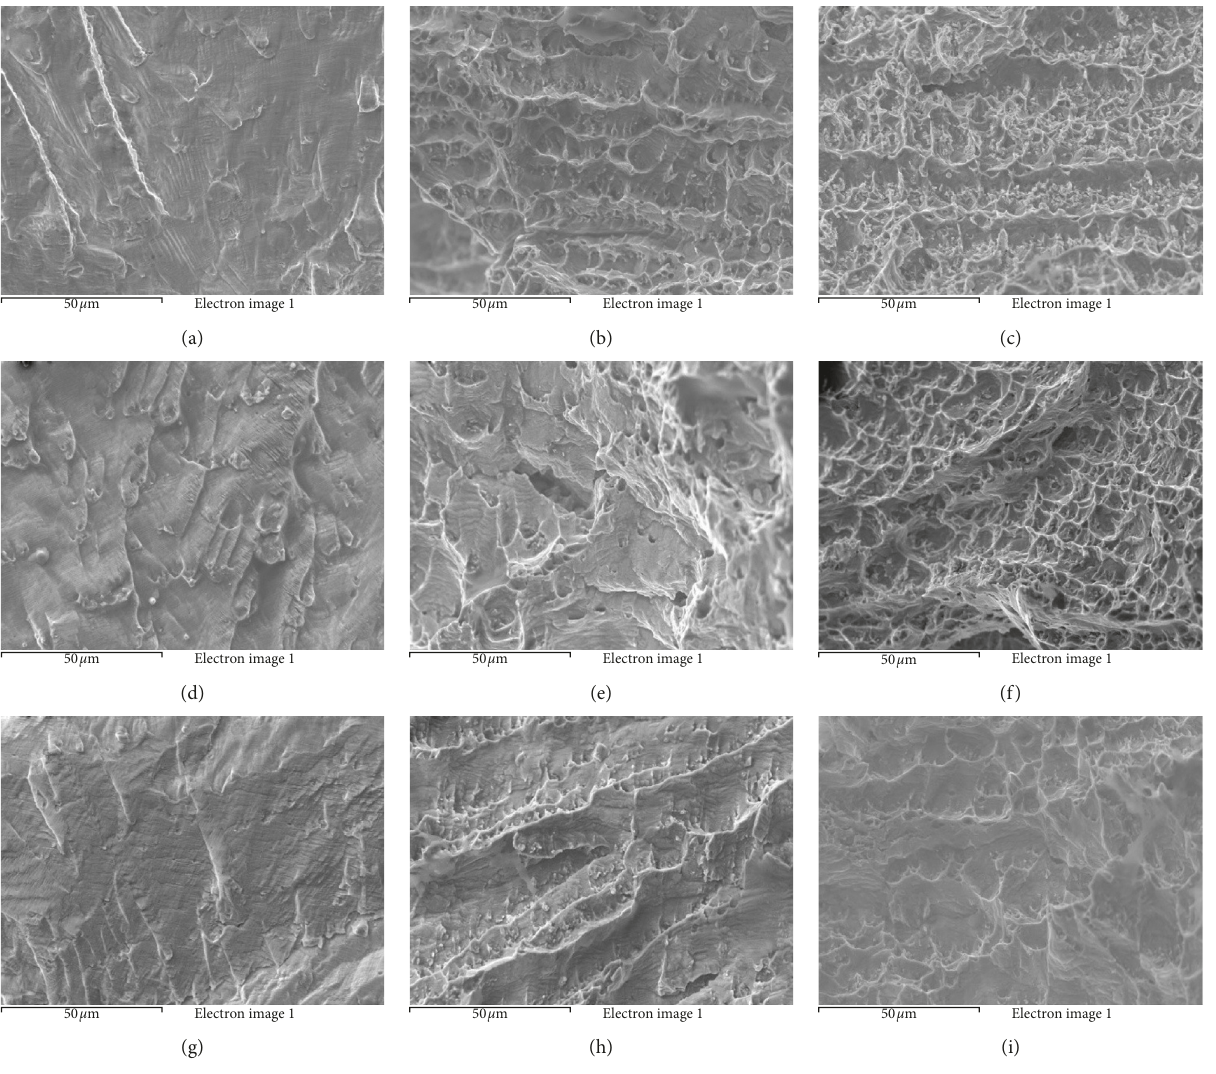
Figure 9: CTOD microscopic fracture photo of weld of L360QS/N08825 bimetallic composite pipe welded joint: (a), (b), (c) W1; (d), (e), (f) W2; (g), (h), and (i)